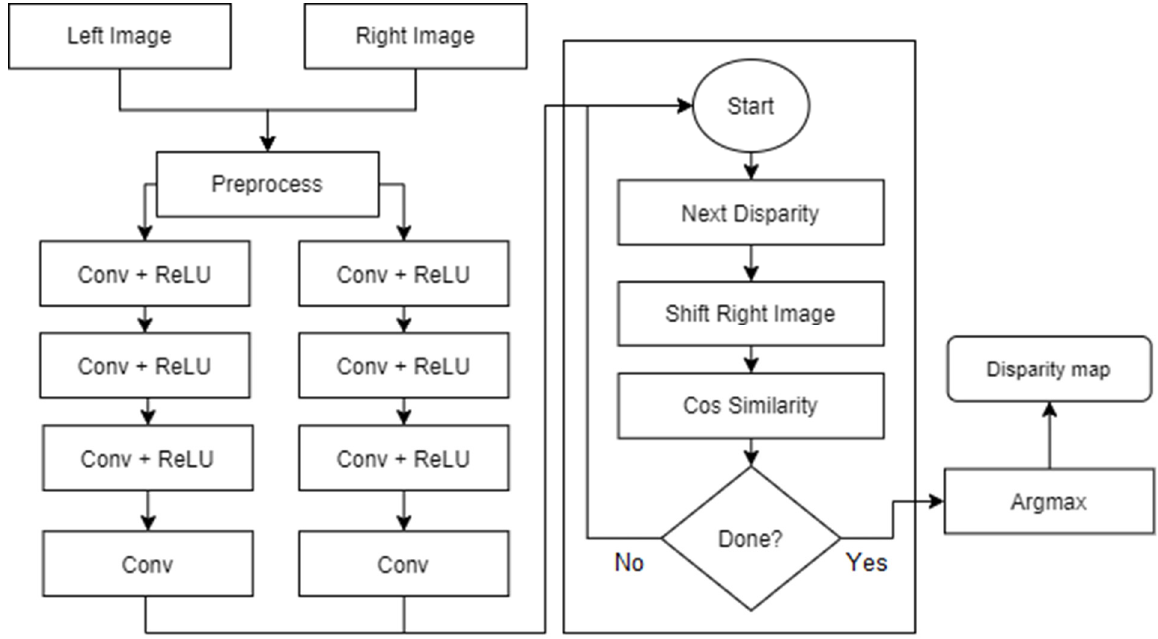
Figure 5. Evaluation flowchart.